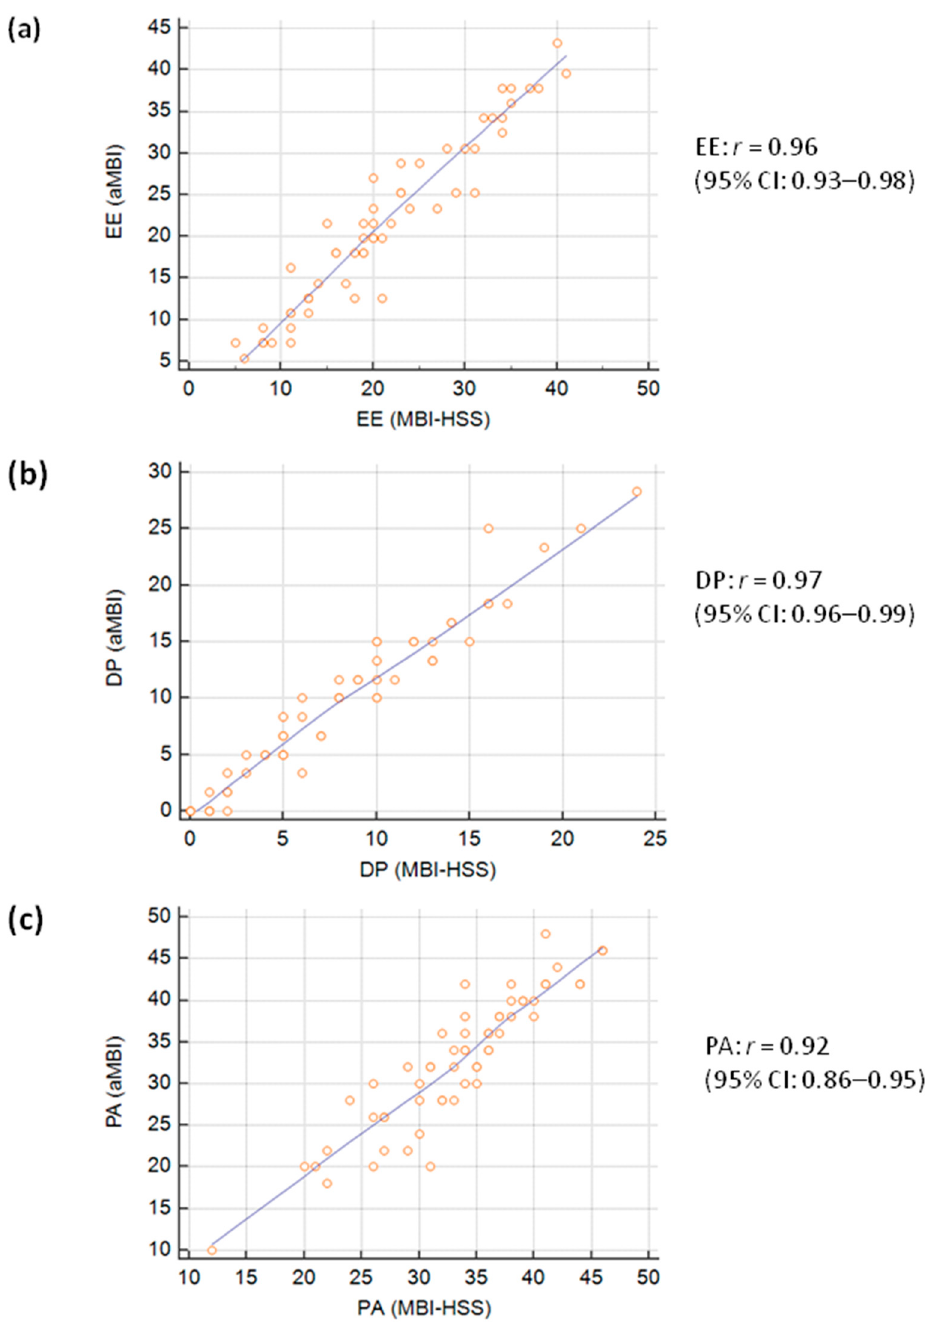
Figure 1. Scatter plots demonstrating the correlation of ( a ) emotional exhaustion (EE), ( b ) Inventory for healthcare professionals (MBI-HSS) and abbreviated MBI depersonalization (DP), and ( c ) personal achievement (PA) scores between the Maslach Burnout Inventory for healthcare professionals (MBI-HSS) and abbreviated MBI (aMBI).